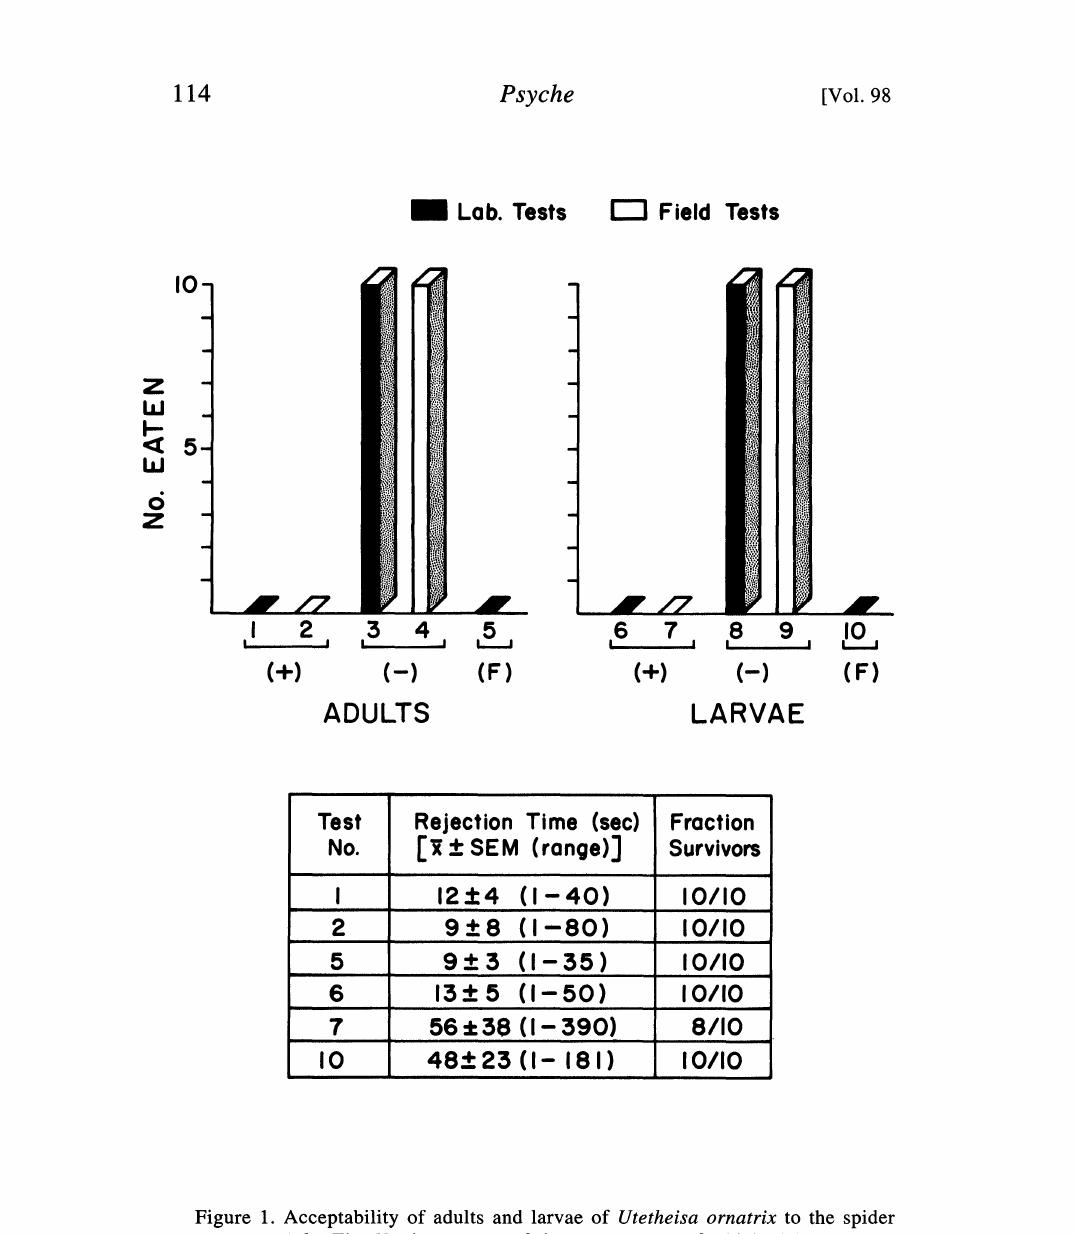
Figure 1. Acceptability of adults and larvae of Utetheisa ornatrix to the spider Lycosa eeratiola. The Utetheisa were of three types, two of which [(+), (F)] con- tained pyrrolizidine alkaloid. The tests are numbered on the x-axis, in accord with the listing in the text. Sample size is N 10 prey items per test. Further details in